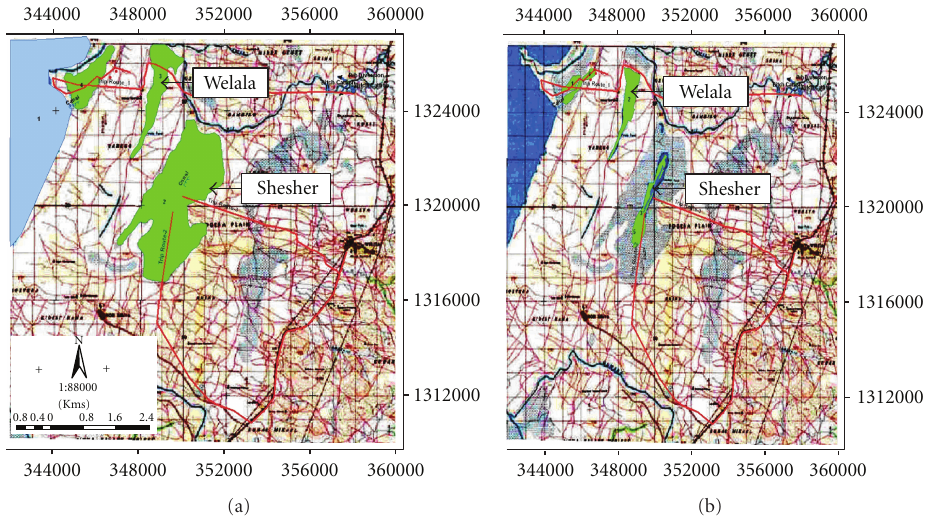
Figure 2: Extent of Shesher and Welala wetlands in 1987 (a) and their current (2008) extent (b) (after Nemomissa [19]).